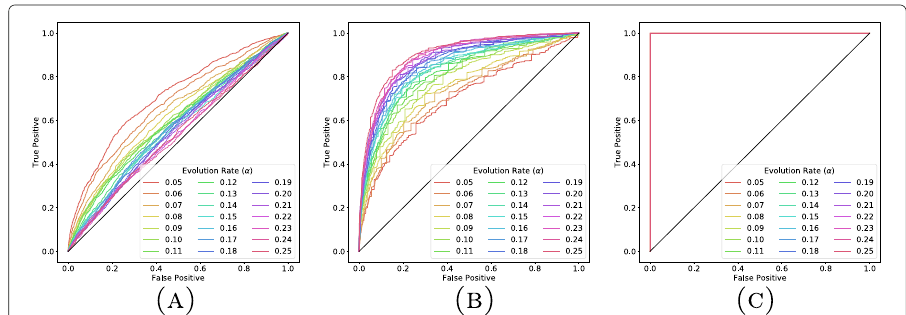
Fig. 6 Power-Law, Lateral Movement, 50 edges. a Kolmogorov-Smirnov. b Relative Hausdorff. c Edit